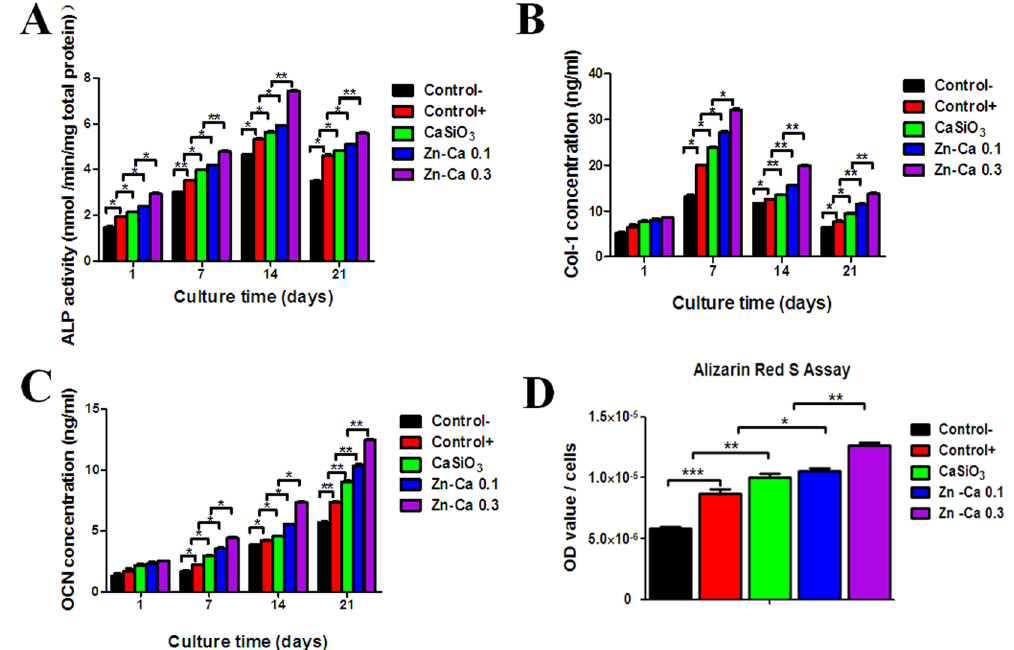
3 , Zn-Ca 0.1 and Zn-Ca 0.3 coating surfaces with or without the osteogenic medium at 1, 7, 14 and 21 days. ( D ) Semi-quantitative analysis of in vitro matrix deposition mineralization was performed at 21 days by Alizarin red S staining. Negative control: BM-PCs on Ti-6Al-4V with growth medium. Positive control: BM-PCs on Ti-6Al-4V with osteogenic medium. Each value represents the mean ± SD from triplicate determinations. * p < 0.05, ** p < 0.01, *** p <